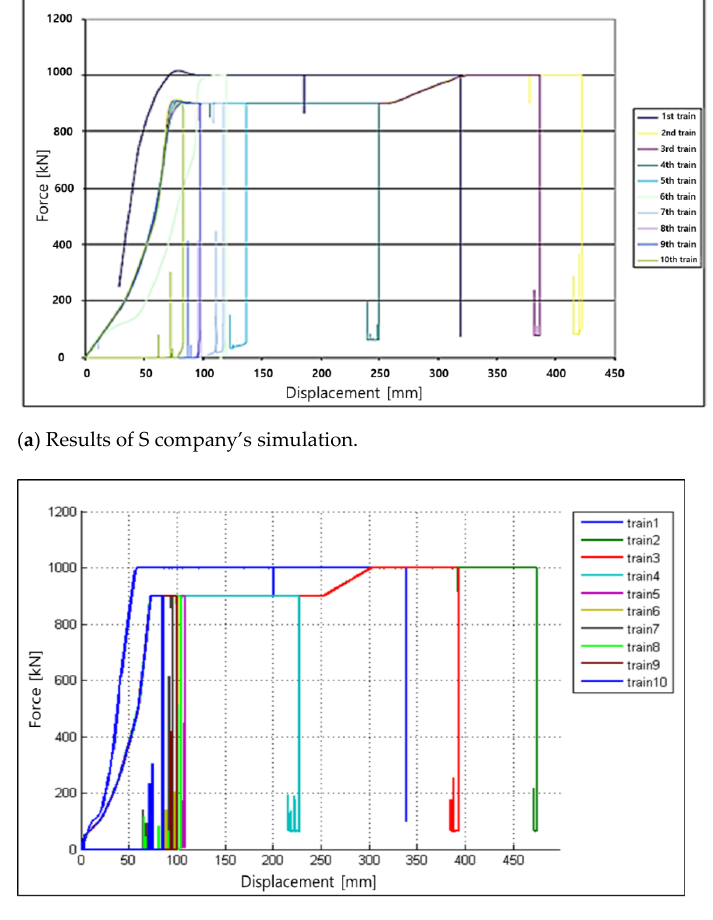
Figure 23. Comparison of reaction force